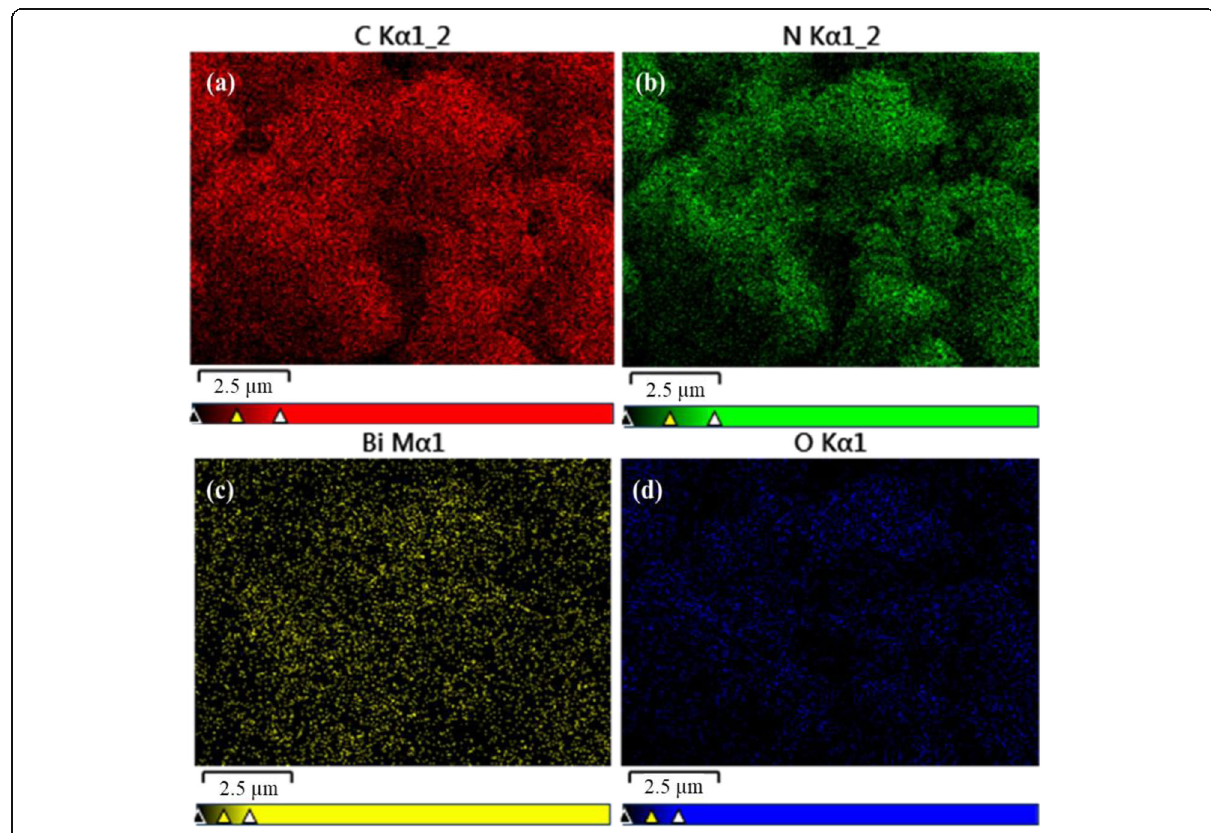
Fig. 2 EDS elemental mapping ( a ) C, ( b ) N, ( c ) Bi and ( d ) O of 1 wt% α -Bi 2 O 3 @g-C 3 N